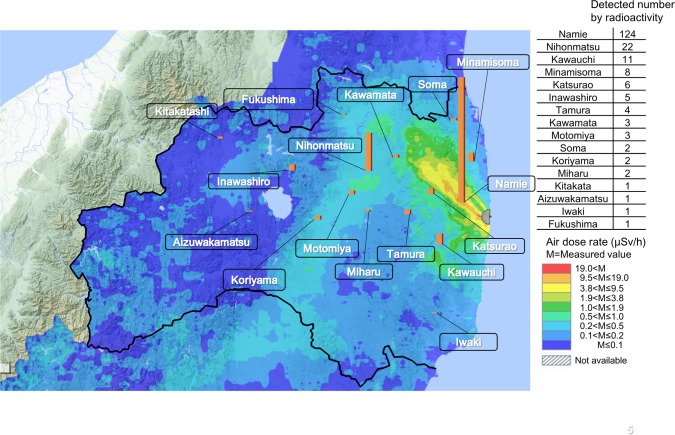
Number of radioactive mushrooms detected.Mushroom activity was higher in areas with a high external gamma dose rate.